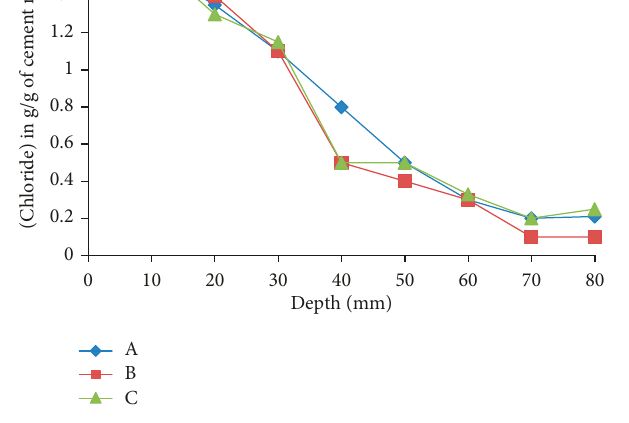
Figure 9: Chloride profiles at w/c 0.6.